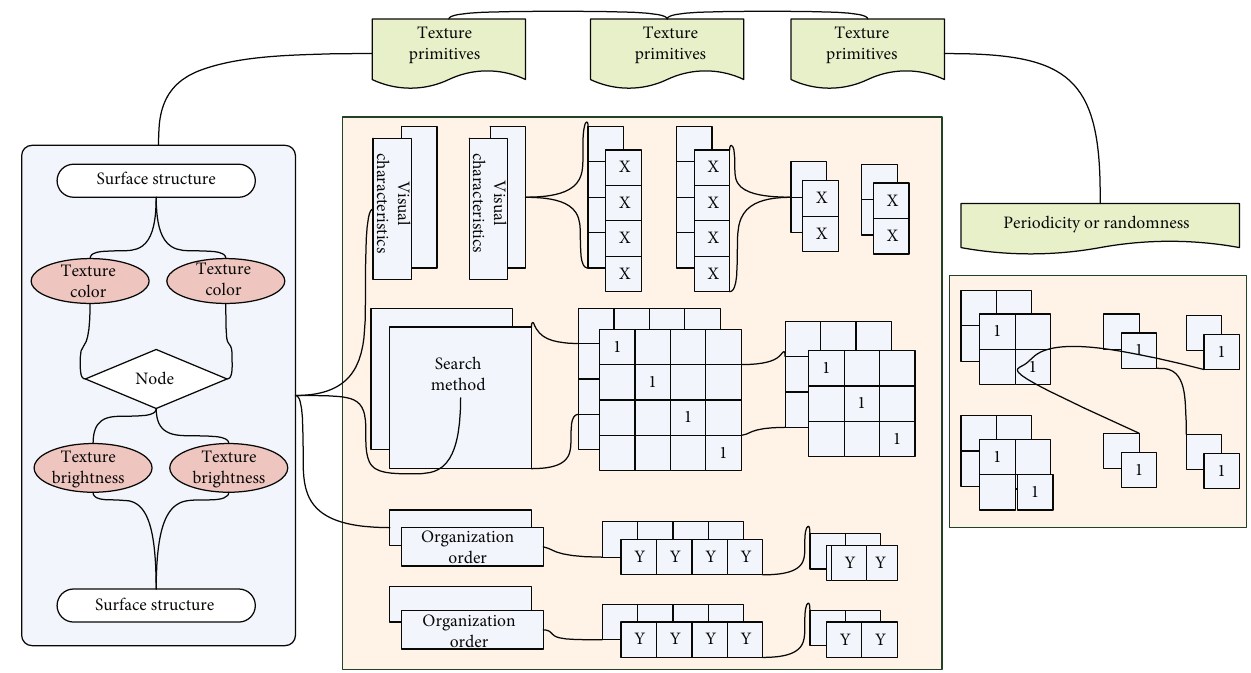
Figure 2: Flow chart of oil painting texture feature extraction.